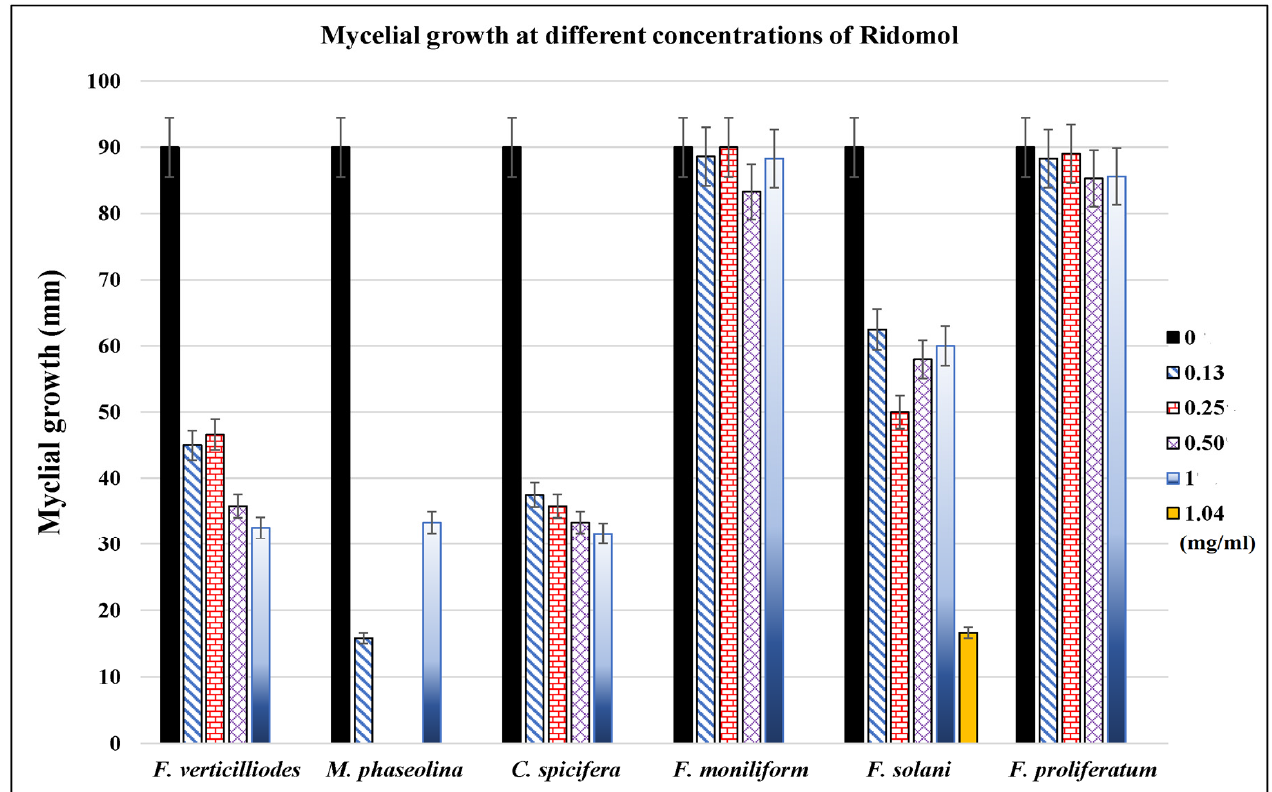
Figure 4. Effect of different concentrations (0, 0.13, 0.25, 0.5, 1, and 1.4 mg/mL) of Ridomol on growth of different phytopathogenic fungi. The antifungal agent showed variable inhibitory effects on the growth of different phytopathogenic fungi cultured on PDA agar medium. Bars indicate the standard error.